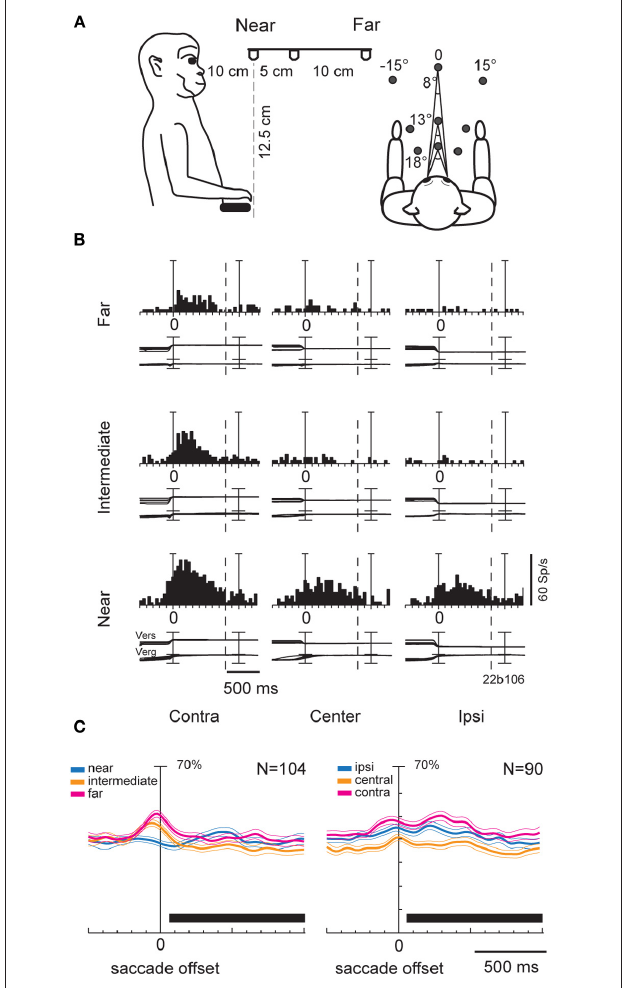
FIGURE 2 | (A) Scheme of the experimental setup set up used for the fixation-in-depth and reaching-in-depth tasks. Exact distances and angles of the targets are indicated in the lateral view (left) and top view (right), respectively. (B) Example of a V6A neuron modulated by both version and vergence during fixation. The discharge to the nine LEDs arranged from near (bottom) to far (top) was aligned twice (at the start of the fixation and at the LED change; dashed line: point where trials were cut because of double alignment). From left to right, the behavioral events are: LED onset, saccade offset (first alignment marker), LED change (second alignment marker). The cell has a clear preference for the near-contralateral space. Bin size for spike histograms: 20ms; scale for version and vergence traces is 100 and 20 ◦ , respectively. (C) Population activity of V6A neurons modulated during fixation. Population average spike density functions (SDF) were constructed by ranking the response for each tested row of fixation targets. The thick lines indicate average normalized SDF; the light lines indicate variability bands (SEM). The peak of the SDF of the row showing the maximum activity was set to 1 (100%) and was used to normalize the SDF curves of the other rows. Activity is aligned with the offset of the saccade. The black rectangles below each plot indicate the periods where the permutation test was run. In the left plot, no statistical difference was observed between the curves (permutation test, p > 0 . 05), whereas in the right, the central row is statistically different from the other two (permutation test, p < 0 . 05). Scale on abscissa: 100ms/division; vertical scale: 70% of normalized activity (10% per division). (A–C) panels were modified from Breveglieri et al.